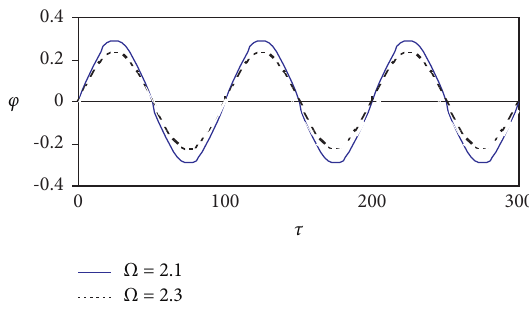
Figure 3: The analytical solutions for case (i) in Section 4.1.